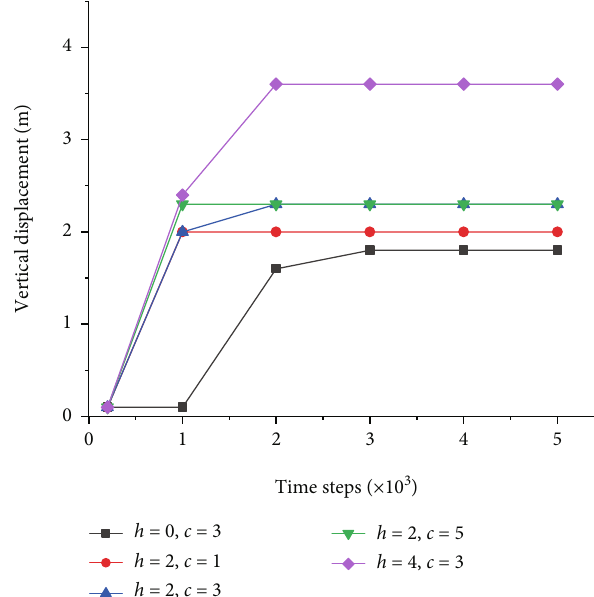
Figure 11: Vertical displacement of the arch